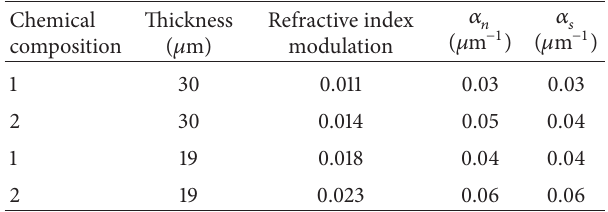
Table 2: Main parameters fitted from the angular response for chemical compositions 1 and 2 after